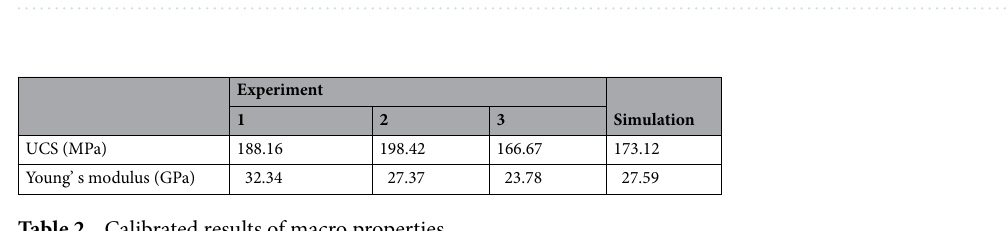
Table 1. Calibrated microproperties used in PFC 2D to present the marine shale specimen.